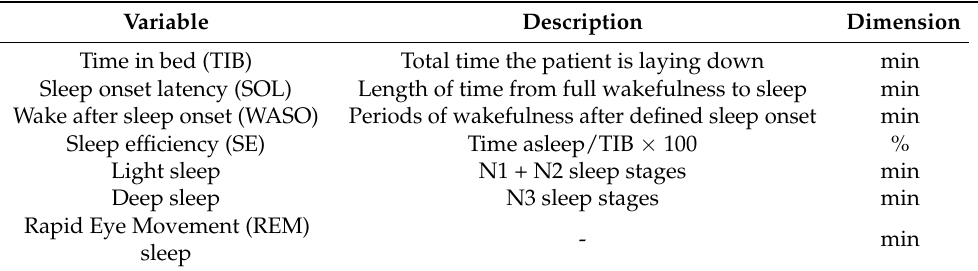
Table 1. Summary of the features of interest for our